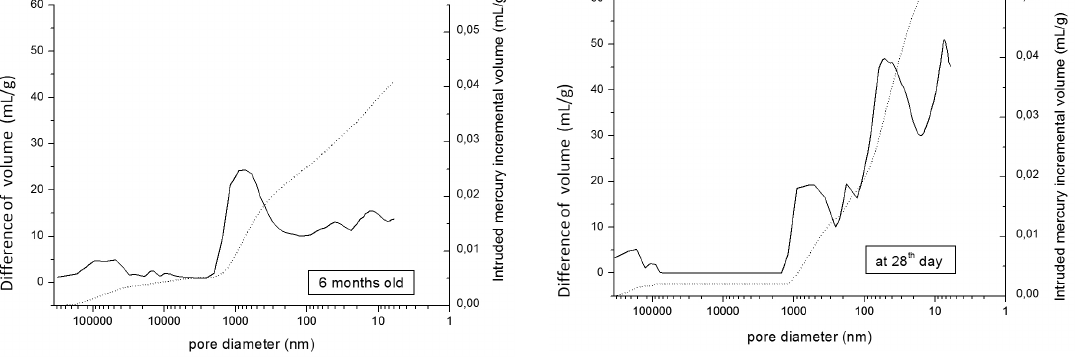
Figure 12. Porosimetry of fiber cement B at six months of age.